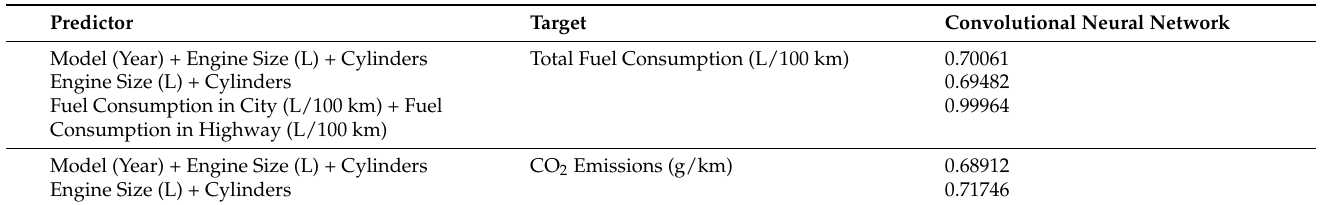
Table 14. Coefficient of determination (R squared) values of Convolutional Neural